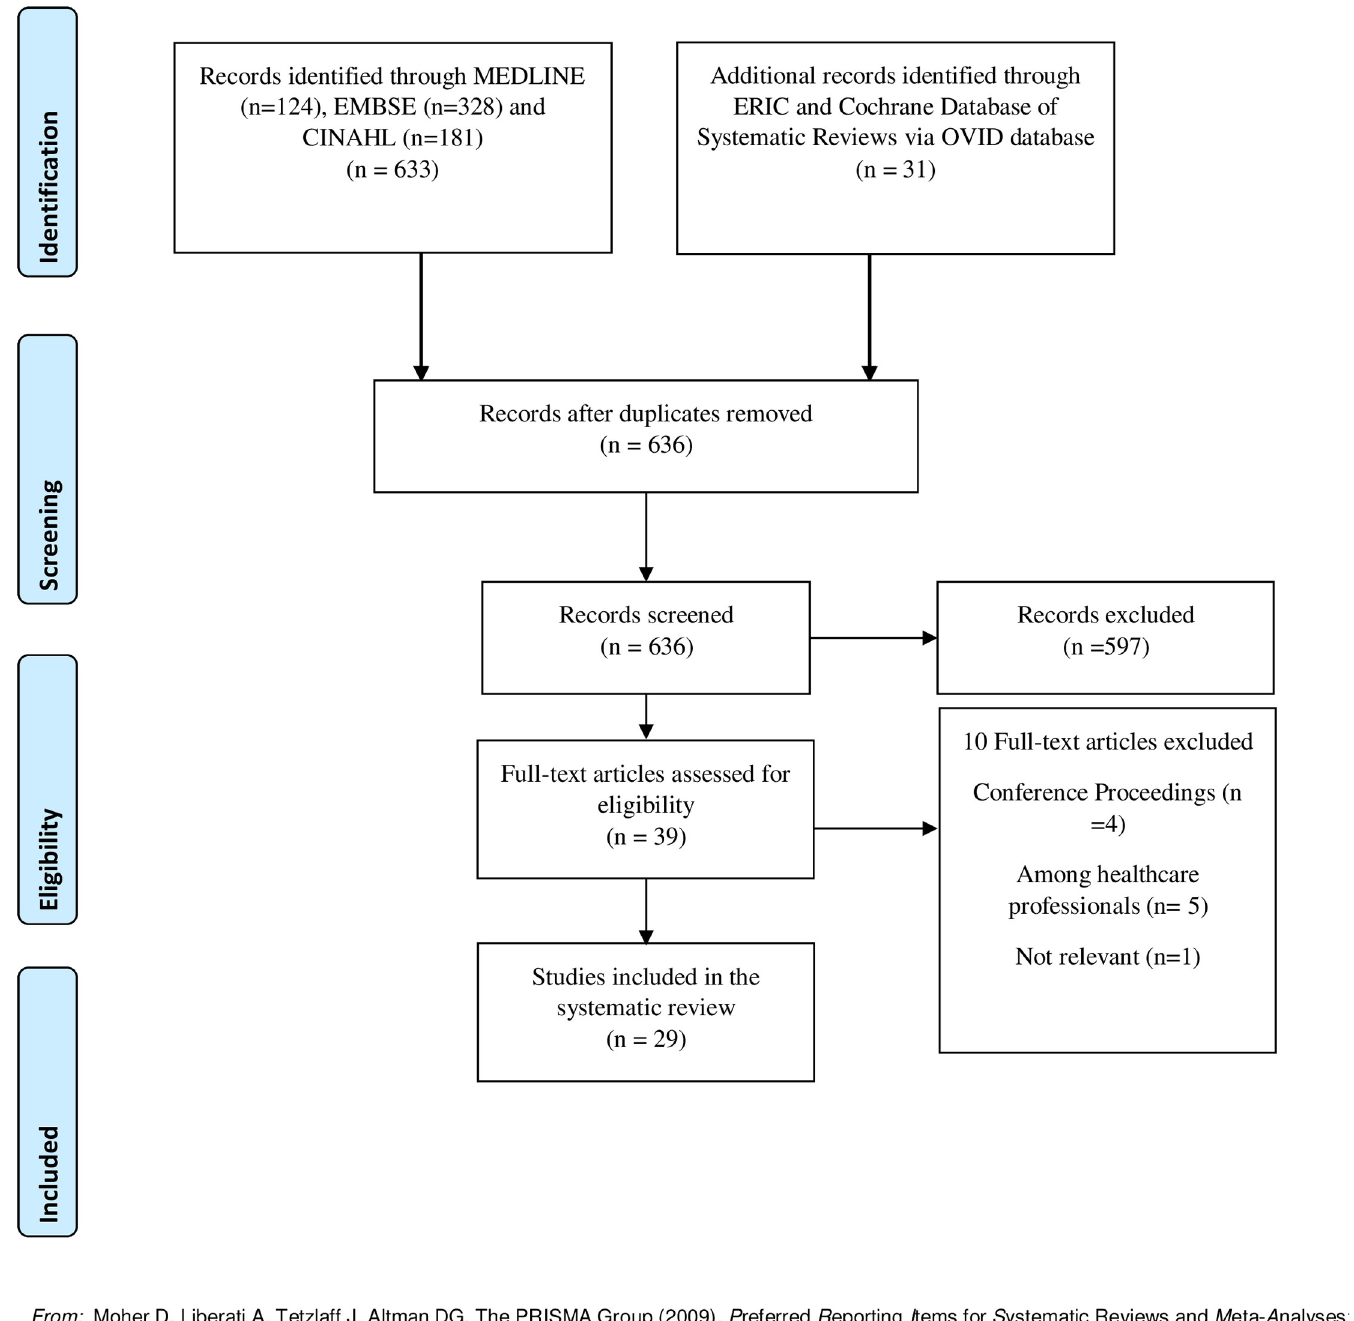
Fig 1. PRISMA flow diagram. From : Moher D, Liberati A, Tetzlaff J, Altman DG, The PRISMA Group (2009). P referred R eporting I tems for S ystematic Reviews and M eta- A nalyses: The PRISMA Statement. PLoS Med 6(7): e1000097. doi: 10.1371/journal.pmed1000097 For more information, visit www.prisma-statement.org.